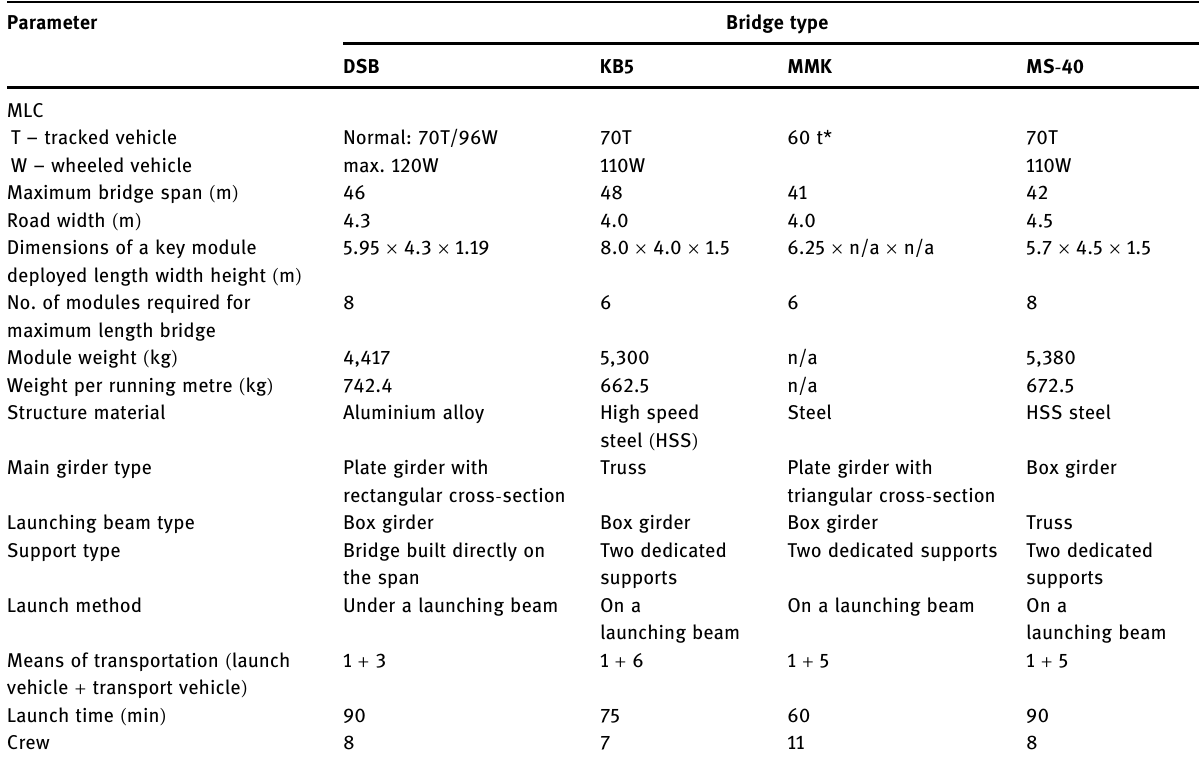
Table 2: Comparison of the selected parameters of support bridges